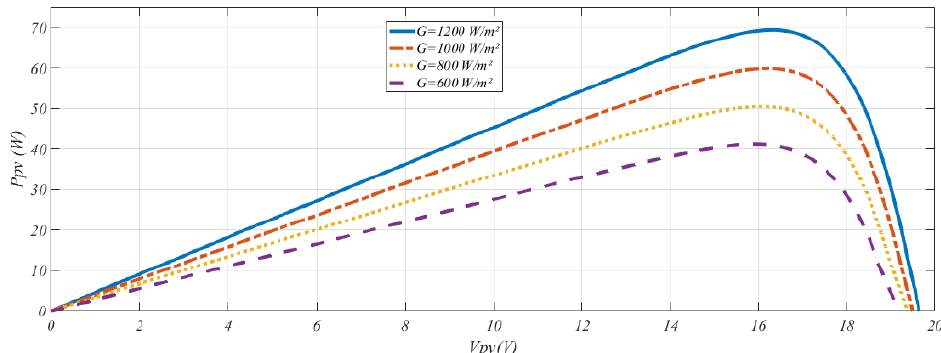
Figure 3. Ppv = f(Vpv) of the PV Generator.